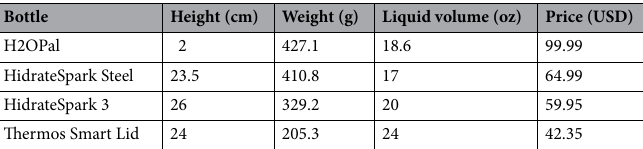
Table 3. The height, weight, volume and price of the bottles.